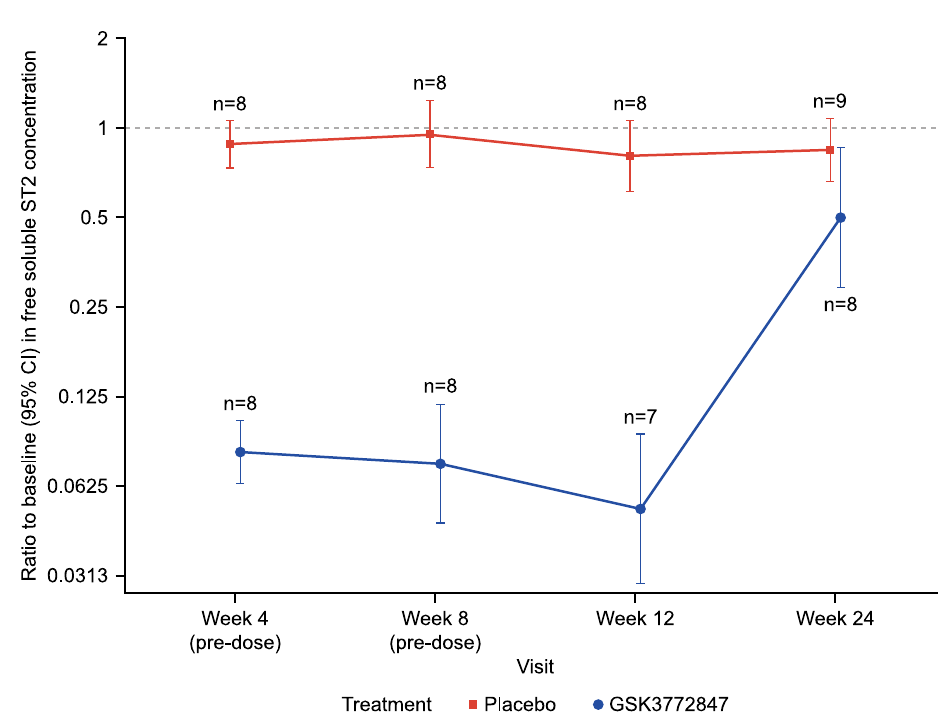
Fig 2. Ratio to baseline in free soluble ST2 levels � . � This figure includes on- and off-treatment data (on-treatment defined window is 28 days). CI, confidence interval; ST2, suppressor of tumorigenicity 2. The raw data for this figure are provided as S1 Table.